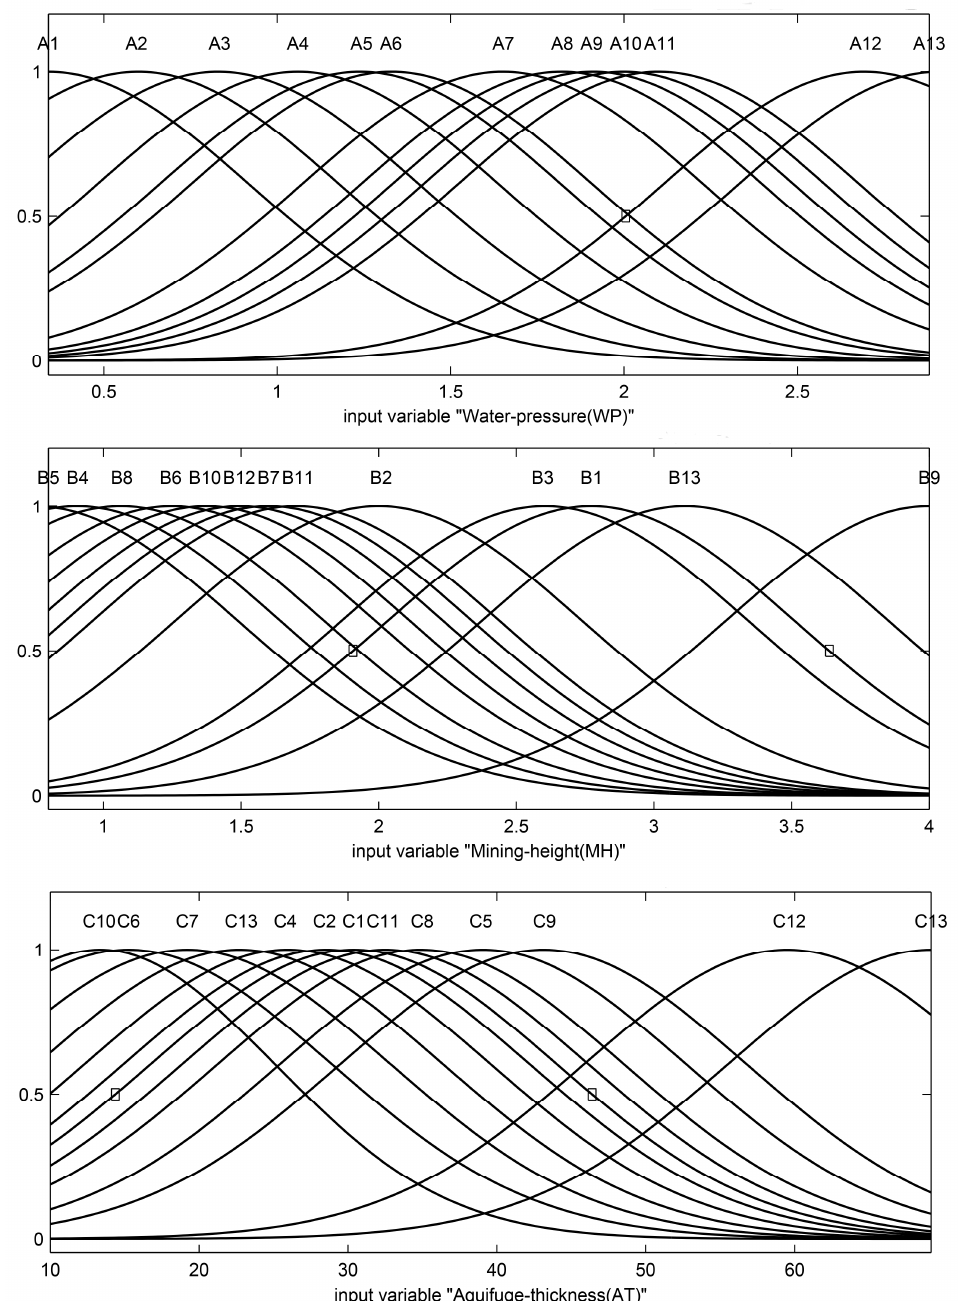
Figure 8. The shape of the membership functions after training (for parameters WP, MH and AT).